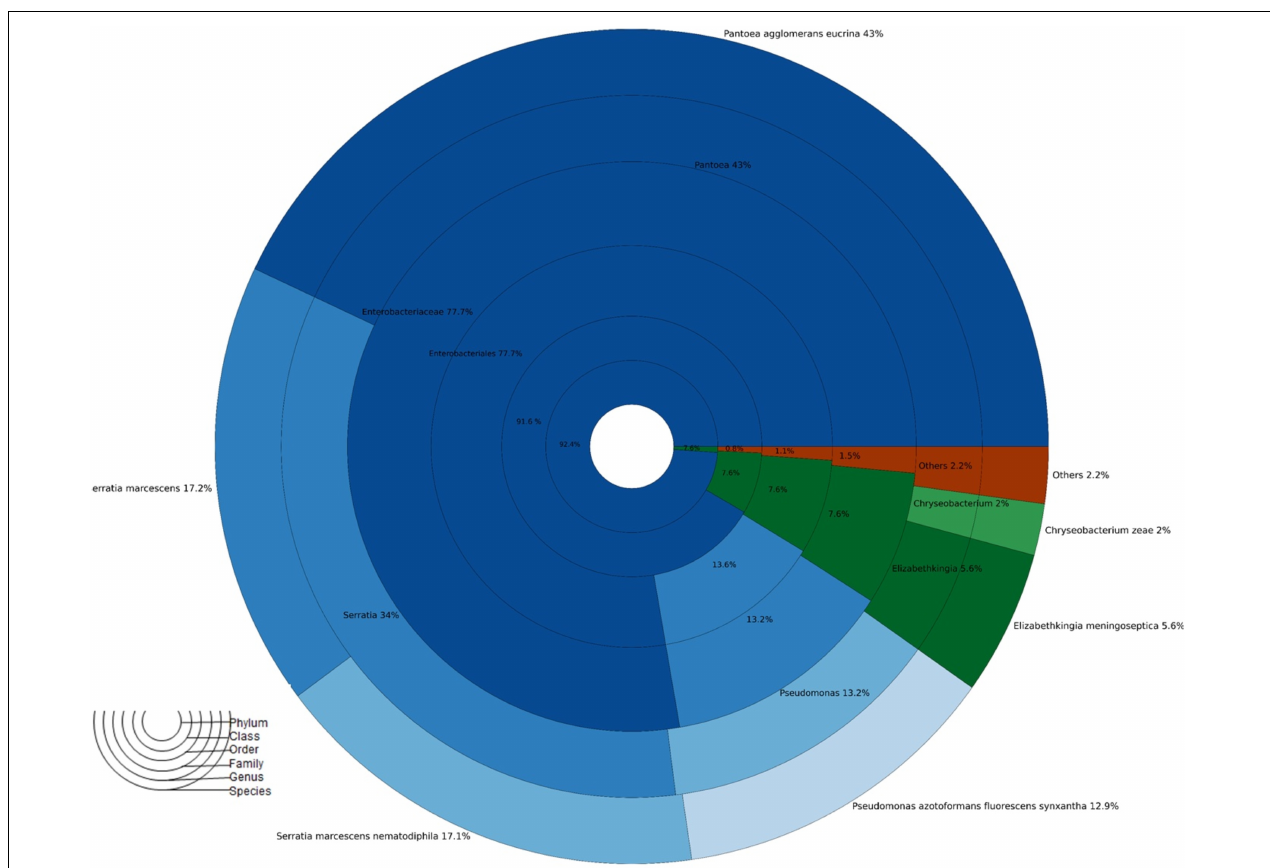
FIGURE 2 | Taxonomic abundance of A. aegypti mosquitoes fed 10% sucrose no exposed to